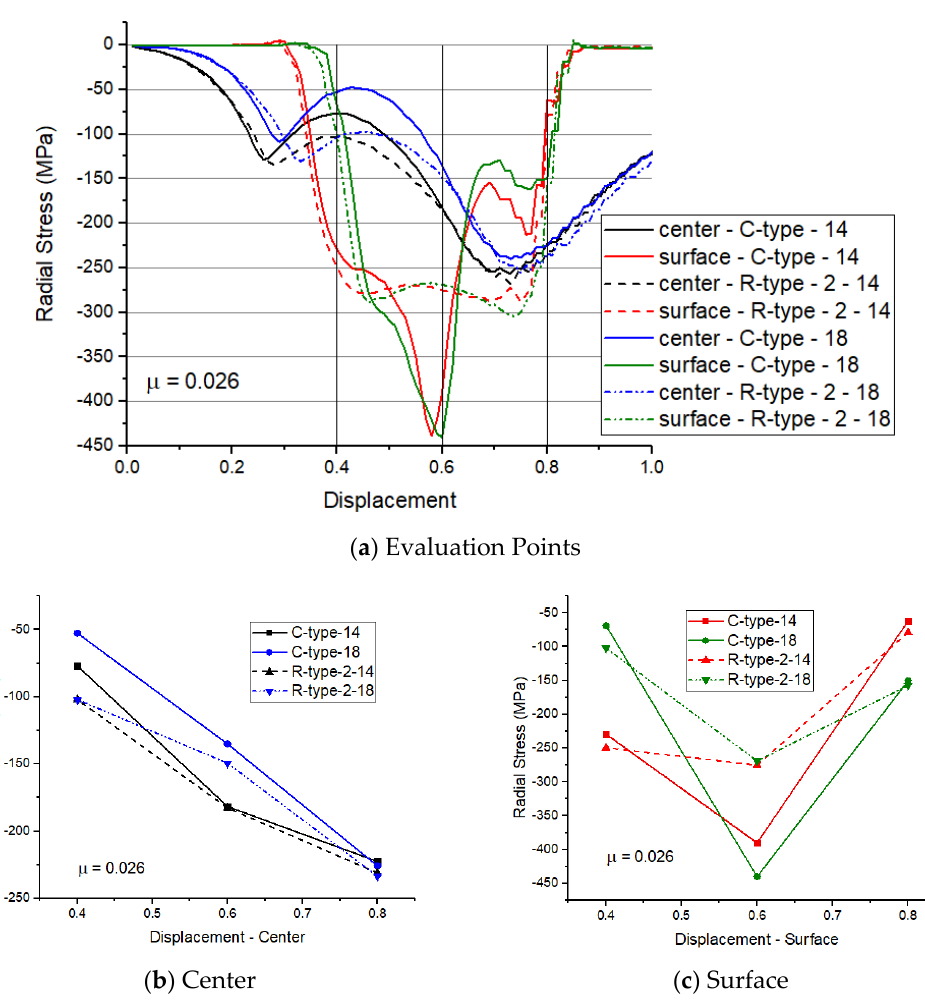
Figure 5. ( a ) Evaluation points. ( b ) The center radial stress as a function of displacement, evaluated for the evaluation points. ( c ) The superficial radial stress as a function of displacement, evaluated for the evaluation points.